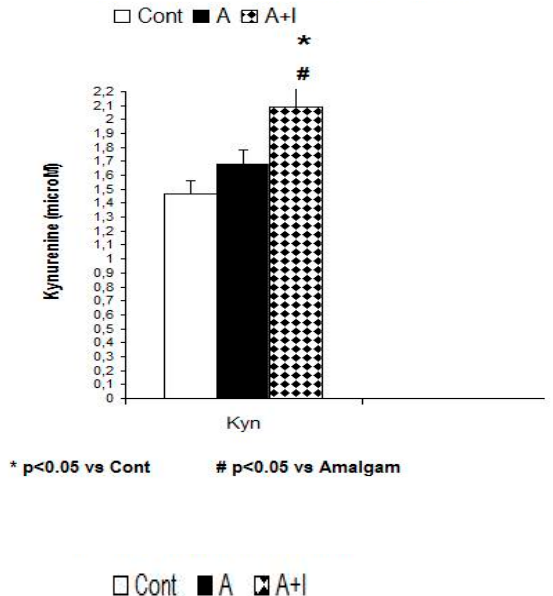
Figure 3. Increased systemic Kyn levels in patients with long-term titanium implants and amalgams (A + I). Cont: control ( n = 30). Amalgam (A, n = 55). Dental titanium implants + Amalgam (A + I, n = 57). * p < 0.05 vs. Control group (Cont), # p < 0.05 vs. Amalgam group (A).